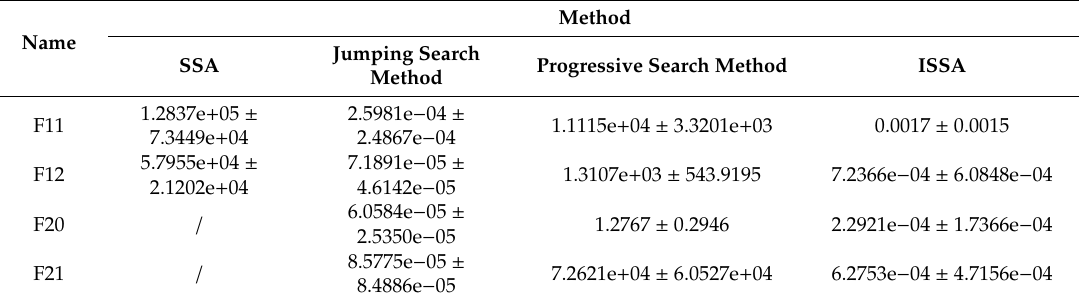
Table 4. The comparison of the population’s fitness